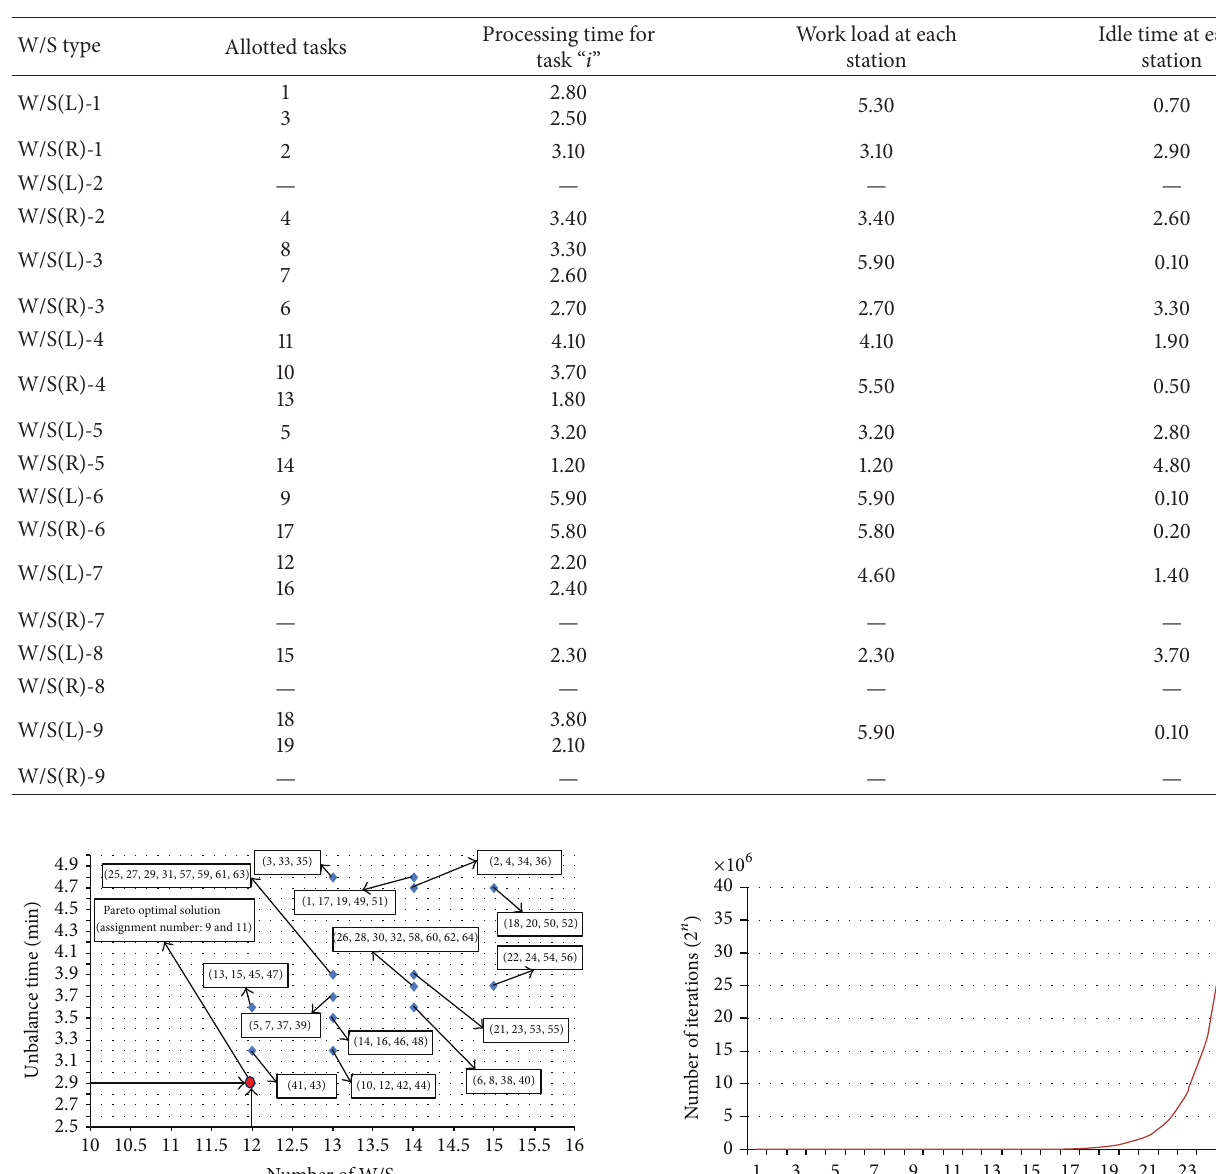
Table 4: Allocation of tasks for 2nd assignment of P19 (CT = 6 min).